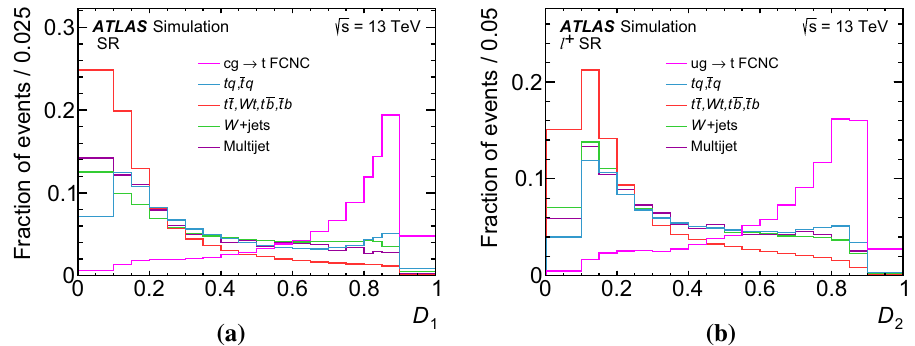
Fig. 4 Distributions of the D 1 and D 2 discriminants for signal and background processes. Each distribution is normalised to unit area. The discriminant D 1 was used for cgt analysis and the (cid:4) − channel of the ugt analysis. The discriminant D 2 was used in the (cid:4) + channel of the Fig. 5 Distributions of the NN discriminants D 1 and D 2 observed in a the tq VR, b the t ¯ t VR and c the (cid:4) + W +jetsVR. The observed data are compared with the distribution of simulated background events normalised to the number of expected events, accounting for the normalisation factors obtained in the fits of the E miss T and m T ( W ) distributions for estimating the multijet background. The uncertainty band represents the uncertainty due to limited sample size and the rate uncertainties of the different processes (20% for W +jets production, 30% for the multijet background and 6% for the top-quark processes). The ratio of observed to predicted (Pred.) numbers of events in each bin is shown in the